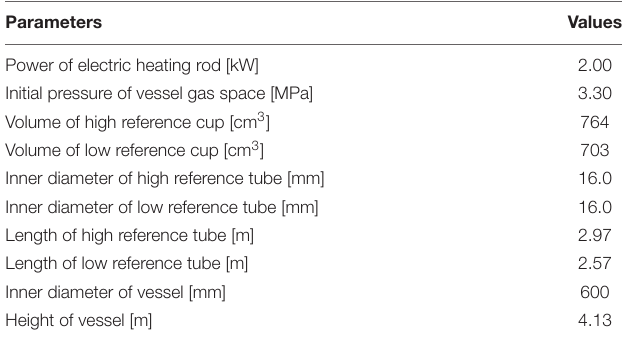
TABLE 1 | Design parameters of the double reference tube level